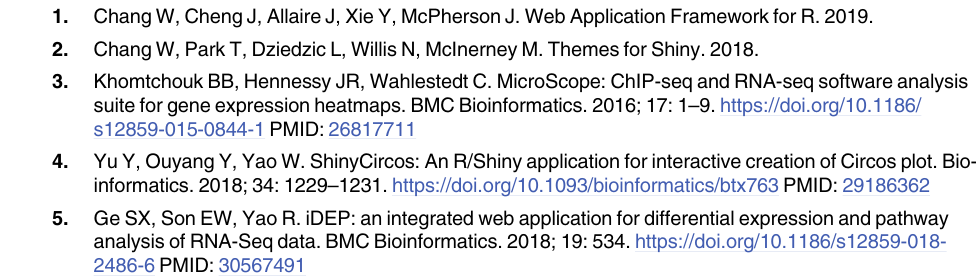
S3 Table. From the second case study, FaDA provides same values than commercial GraphPad Prism (v. 9.1.0) or Microsoft Excel software with less time-consuming data